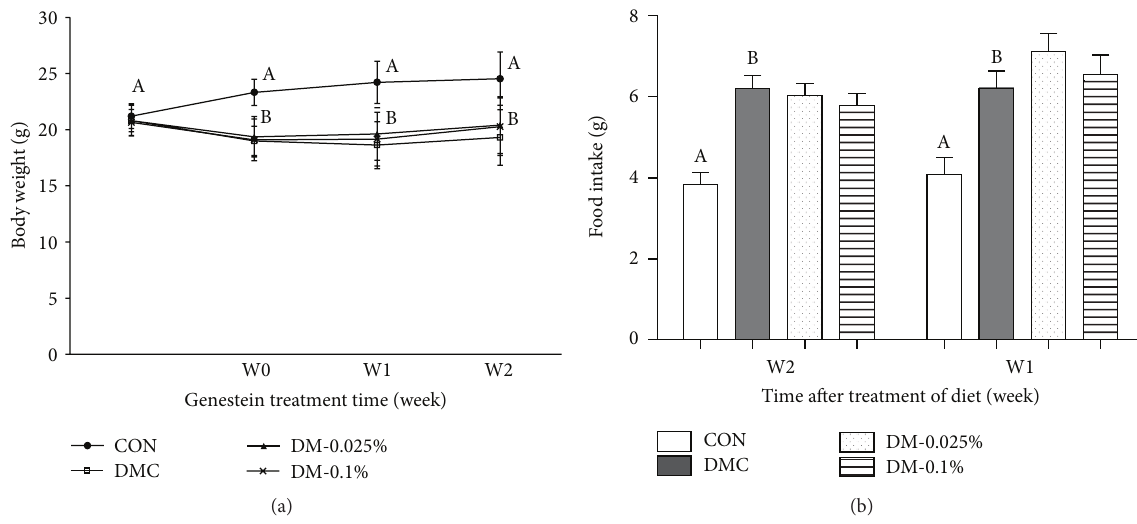
Figure 1: Effect of genistein supplementation on body weight (a) and food intake (b) in experimental mice. Data are presented as means ± SD ( 𝑛 = 9 - 10 /group). Mean values with different letters were significantly different, 𝑃 < 0.05 . Statistical differences of variables between CON and DMH-C analyzed by unpaired t -test were shown in capital letters. CON, control mice; DMC, diabetic control mice; DM-0.025%, diabetic mice supplemented with 0.025% genistein; DM-0.1%, diabetic mice supplemented with 0.1%